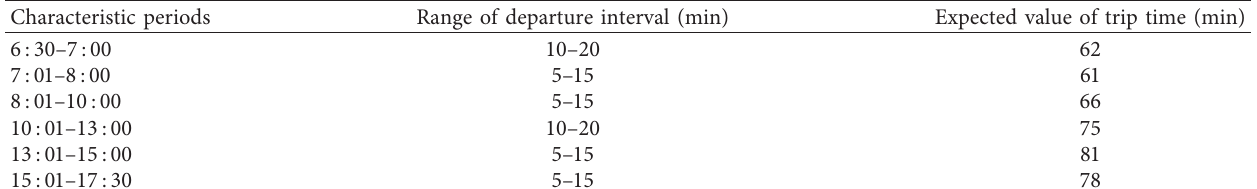
Table 6: Trip time during each period on Route 3 of Jingmen Bus.